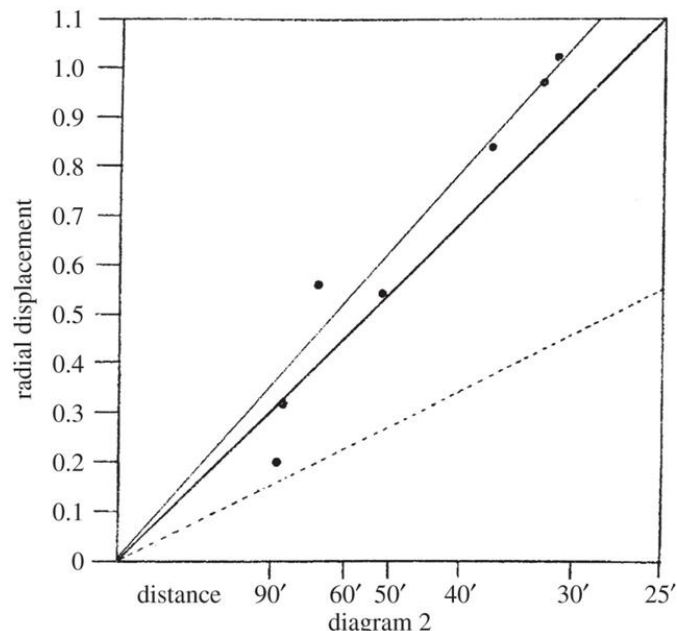
Figure 3. The radial deflections of the positions of seven stars observed by the 4-inch telescope at Sobral as a function of distance from the center of the Sun. The scale on the abscissa is the inverse of the distance from the centre of the Sun. The dotted line shows the Newtonian prediction and the central heavy solid line shows the expectation of the General Theory of Relativity. The upper light solid line shows a best-fit to the deflection of the seven stars by the Sun. Image taken from [34].